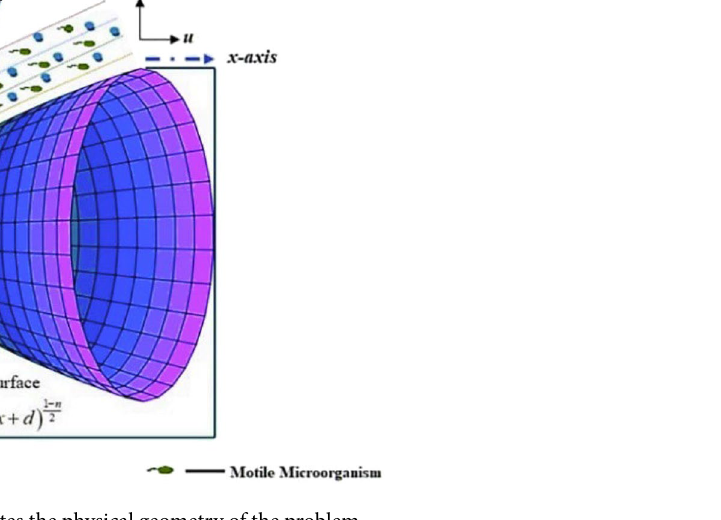
Figure 2. Demonstrates the physical geometry of the